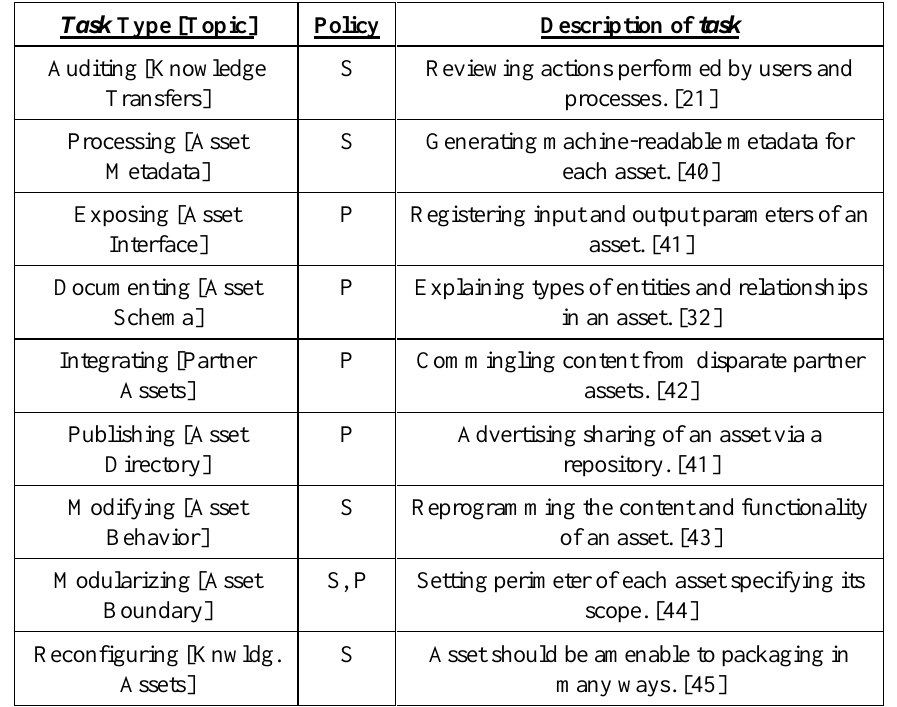
Table 2. Task types and topics in As-Is scenario in Figure